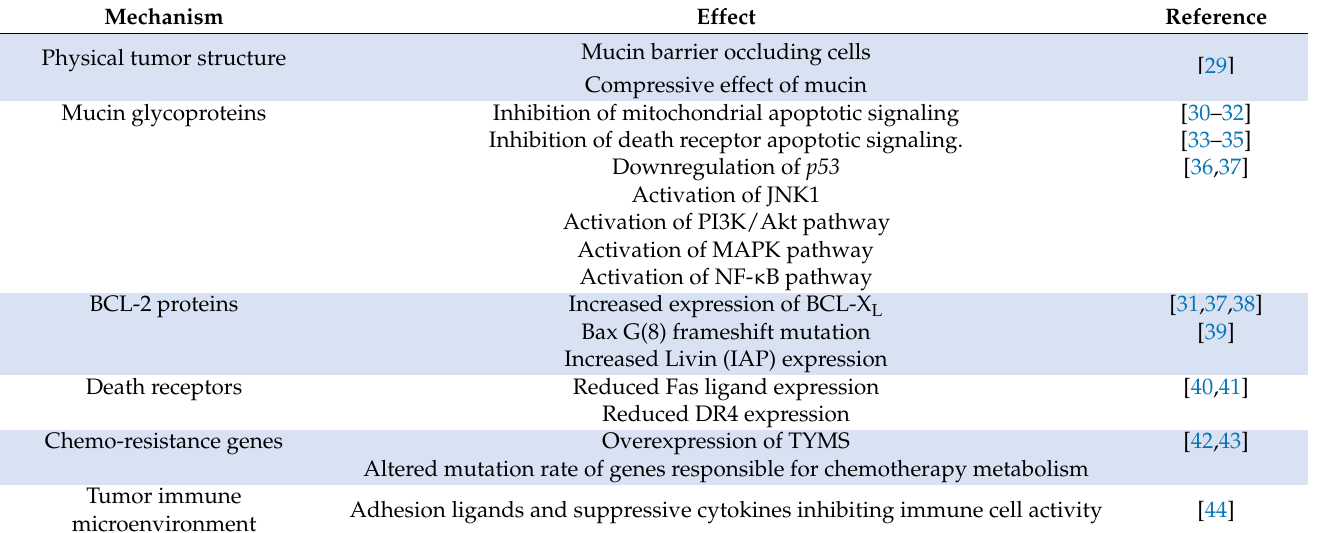
Table 1. Mechanisms for resistance to cell death in mucinous colorectal cancer